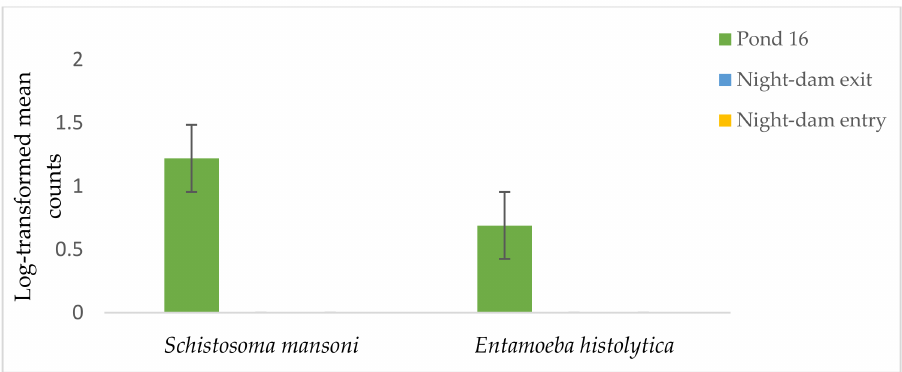
Figure 6. Distribution of log transformed Schistosoma mansoni and Entamoeba histolytica ova in different treated wastewater sources and borehole water used for irrigation at UL Experimental